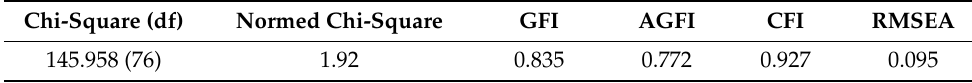
Table 1. Nature Element Model Fit. Chi-Square